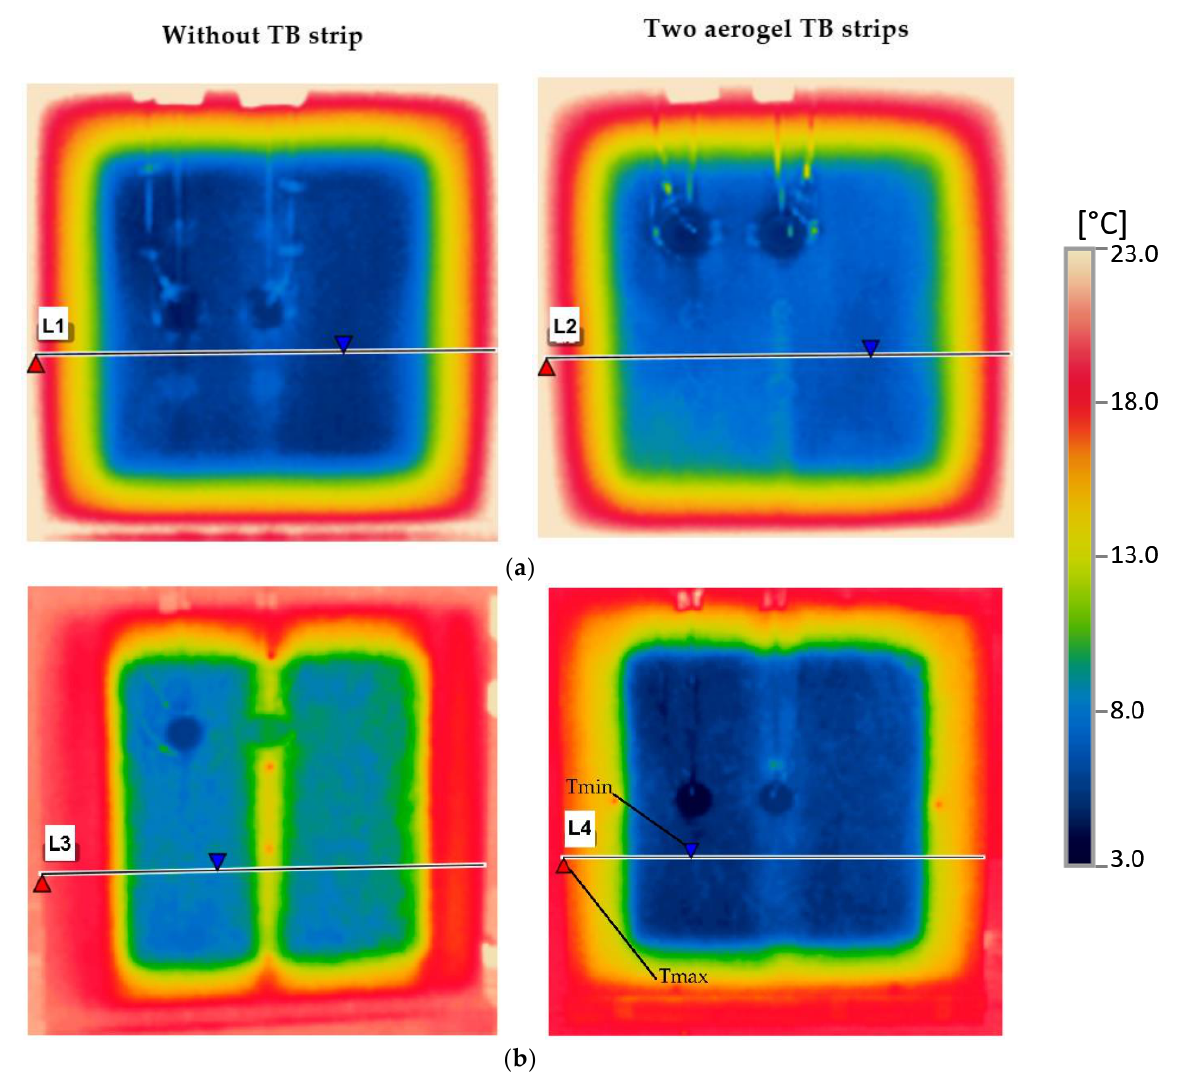
Figure 9. IR images of the LSF walls: cold surface. ( a ) Facade LSF walls. ( b ) Partition LSF walls (adapted from [30]).